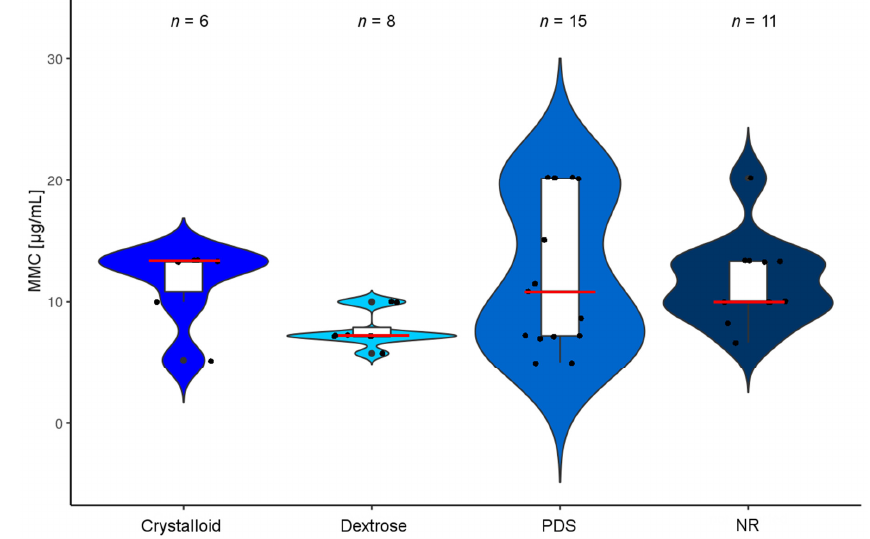
Figure 5. Drug concentration of MMC: The violin plot depicts concentrations of MMC as used in different HIPEC protocols. Protocols were categorized according to the matrix used to dilute drugs (crystalloid, dextrose, PDS or NR). Since there is lacking uniformity and for comparative reasons, we imputed data to a presumed average patient (with characteristics of 1.7 m height, 70 kg weight and 1.73 m 2 body surface area). Further in the case of ambiguity values were maximized using the maximal drug amounts and the minimum diluent volumes reported. The red bars mark medians and white boxes interquartile range. Protocols with missing data or reporting ≤4 patients were omitted. (Median drug concentrations (µg/mL): crystalloid: 13.3; Dextrose: 7.2; PDS: 10.8; NR: 10). Abbreviations used: MMC (mitomycin c); PDS (peritoneal dialysis solution); and NR (not reported).